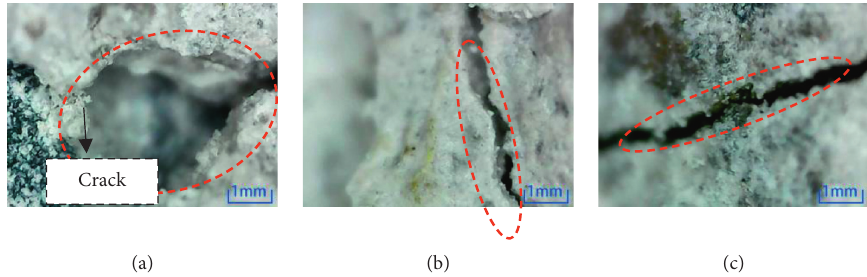
Figure 19: Microscopic observation of position 1 in 100 times freeze-thaw cycles. (a) 0%. (b) 1%. (c) 2%.